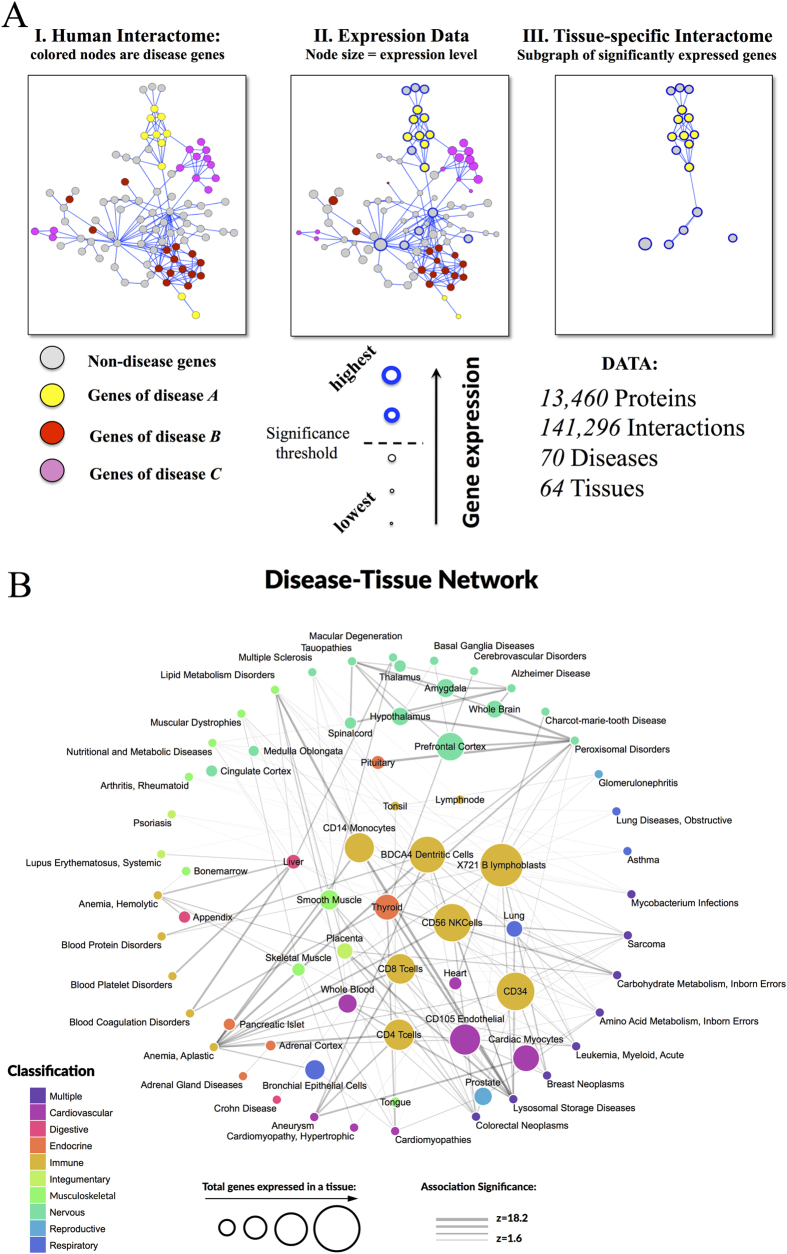
Disease-tissue bipartite network.(A) From left to right: I. Human interactome is compiled and disease-related genes are identified. II. Gene expression data are mapped onto the human interactome. The expression level is reflected in the node size. III. A tissue-specific interactome is constructed as a subgraph of the human interactome consisting of genes expressed with significance zE ≥ 1.0. Disease A has significantly connected module within the tissue-specific interactome, while diseases B and C do not. (B) Disease-tissue bipartite network. Tissues are placed within the circle while diseases are positioned along the circumference. Nodes are colored according to tissue classification. The sizes of tissue nodes are proportional to the total number of genes expressed in them. The widths of connecting links correspond to the significance of the association. For higher resolution see Fig. S6.